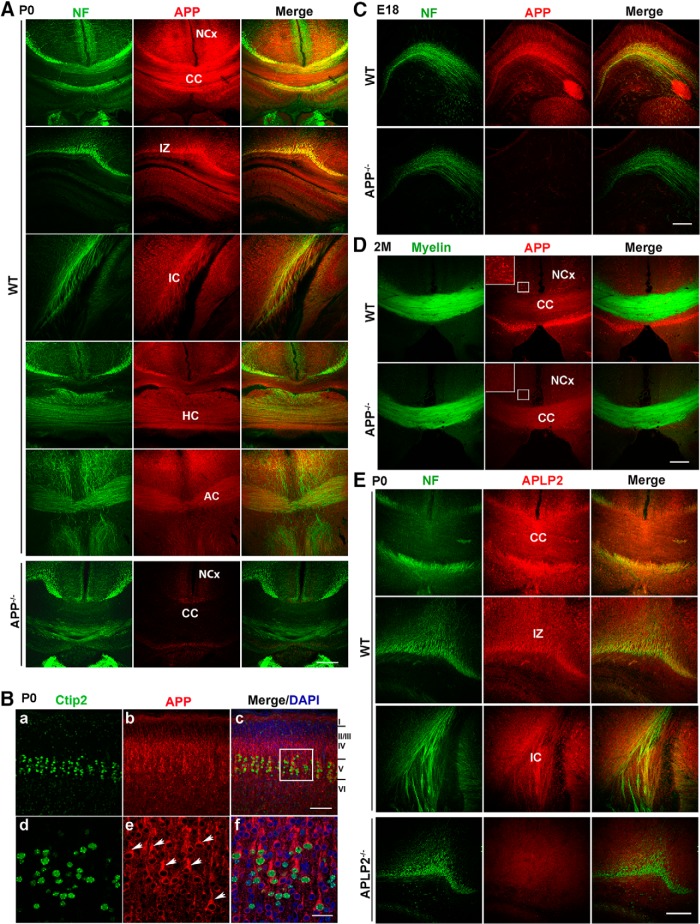
Expression of APP in developing axons and projection neurons. A, APP and neurofilament (NF) double immunostaining in P0 WT mouse brains, revealing abundant APP expression in axonal tracks of CC, IZ, and IC, HC, and AC. APP−/−, a corresponding CC section of APP null mice; NCx, neocortex. B, APP and Ctip2 double immunostaining in P0 WT mouse cortex (with Layers I-VI marked on right). d–f are high resolution images of bracketed areas in c highlighting prominent expression of APP (red, arrow heads) in Ctip2-positive Layer V projection neurons (green). C, NF and APP double staining, showing positive axonal expression of APP in E18 WT, but not APP−/−, mouse brains. D, Two-month-old WT and APP−/− brain sections were double stained with APP and FluoroMyelin Green. Bracketed areas are enlarged view showing APP expression in the neuronal cell bodies. E, APLP2 and NF double immunostaining in P0 WT mouse brains, revealing APLP2 expression in axonal tracks of CC, IZ, and IC. APLP2−/−, a corresponding IC section of APLP2 null mice. Merge: overlay of the single-stained panels. Scale bars, 100 μm [A, B (a–c), C–E] and 20 μm [B (d–f)].